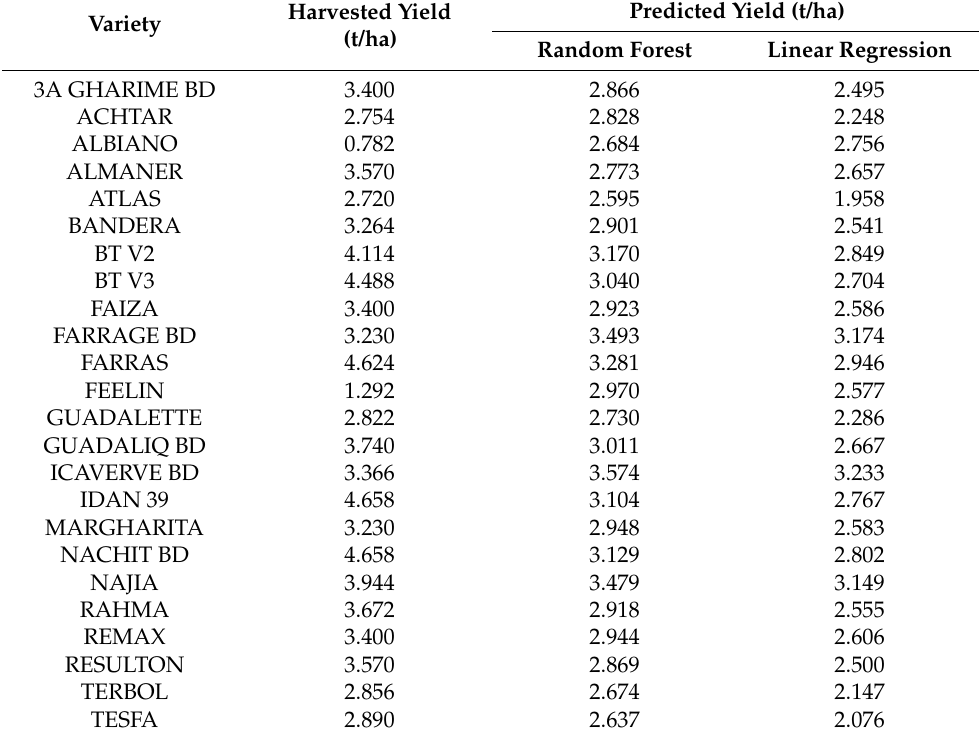
Table 9. Predicted wheat yield using general approach.